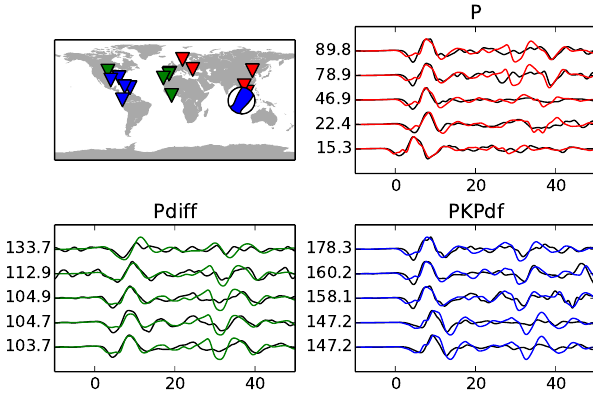
Figure 19. Comparison between observed seismograms (black) and Instaseis synthetics for the Sumatra earthquake on 30 Septem- ber 2009 with magnitude M w 7.5 at 82km depth. Vertical axis la- bels are epicentral distances, horizontal is time relative to the ray- theoretical arrivals. A Gabor filter with 3.7s central period is ap- plied to all traces and the synthetics are convolved with an inverted source time function (Sigloch and Nolet, 2006). The waveforms are aligned by computing relative time-shifts between data and syn- thetic seismograms using cross-correlation (similar to actual finite- frequency